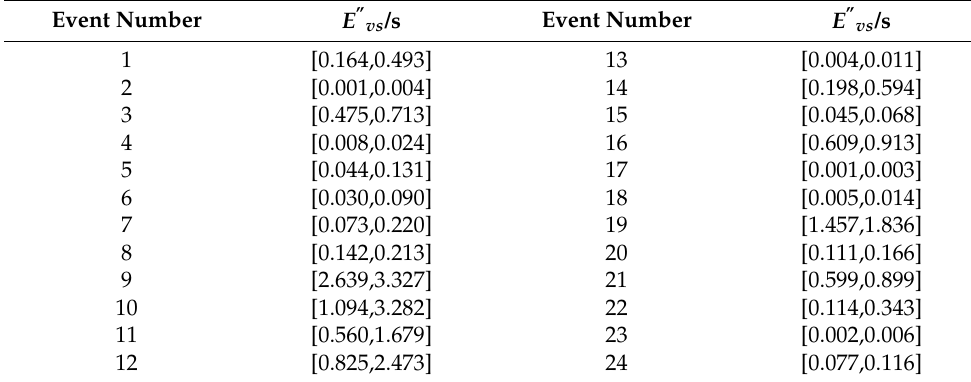
Table 4. Improved energy index after considering sag